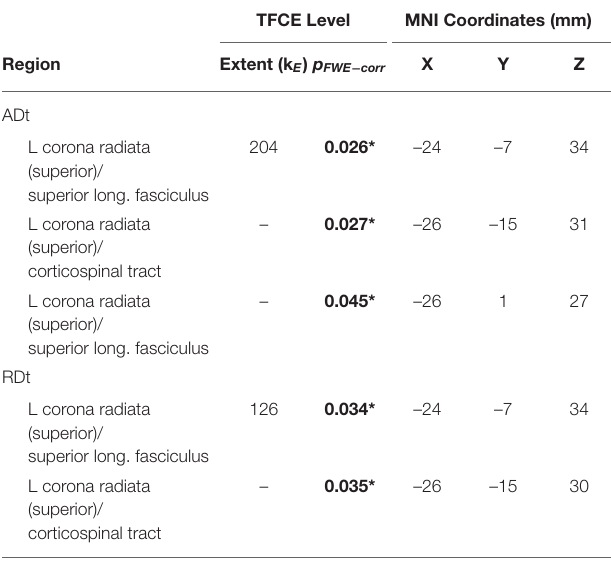
TABLE 4 | Regions of age difference in the relationship of FW-corrected white matter microstructure with the DTcost of gait speed.